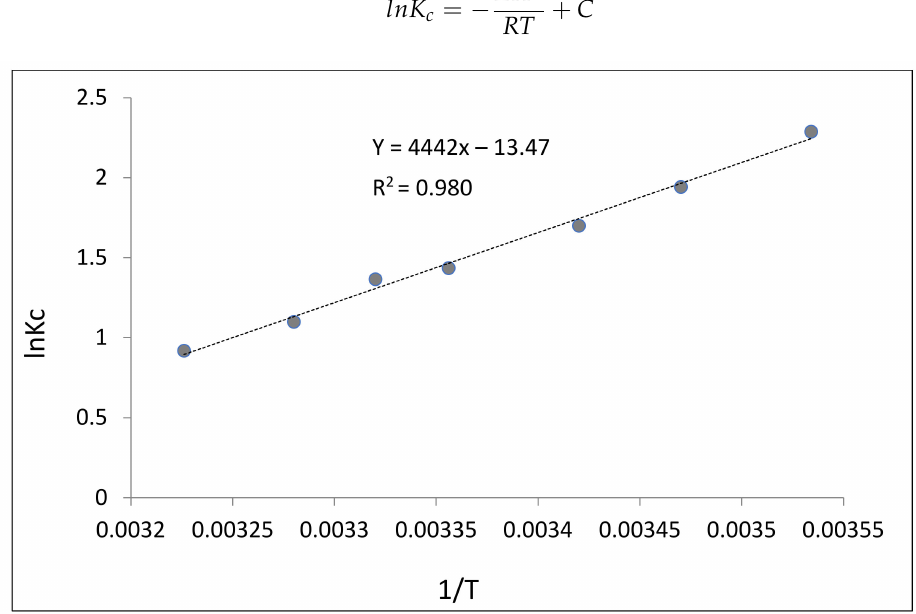
Figure 7. Logarithmic dependence of the equilibrium constants of the fluoride ions adsorption reaction from solution on inverse temperature.